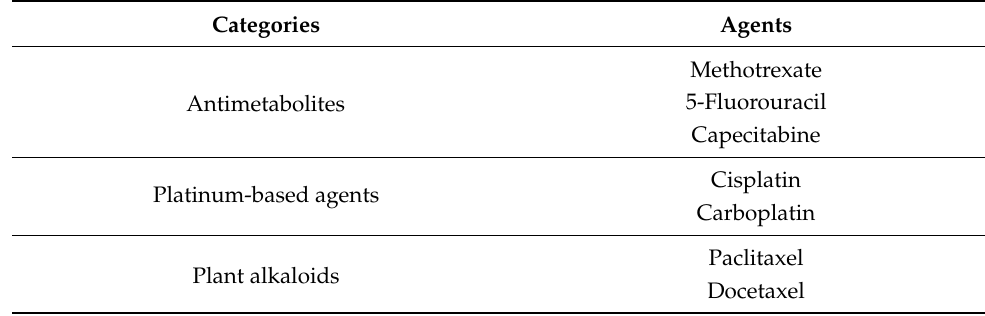
Table 1. Classification of various chemotherapeutic